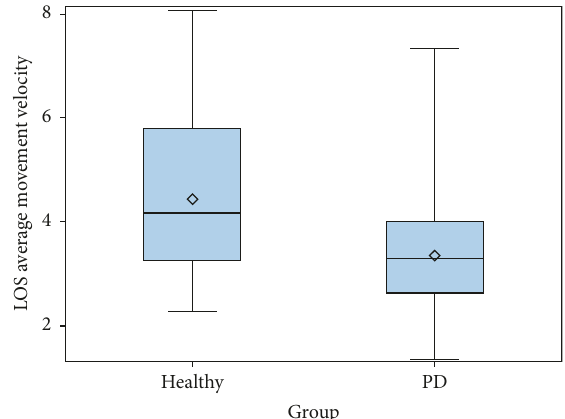
Figure 4: Comparative boxplot of limits of stability average movement velocity performance for Parkinson’s disease and age- matched healthy cohorts. LOS, limits of stability.